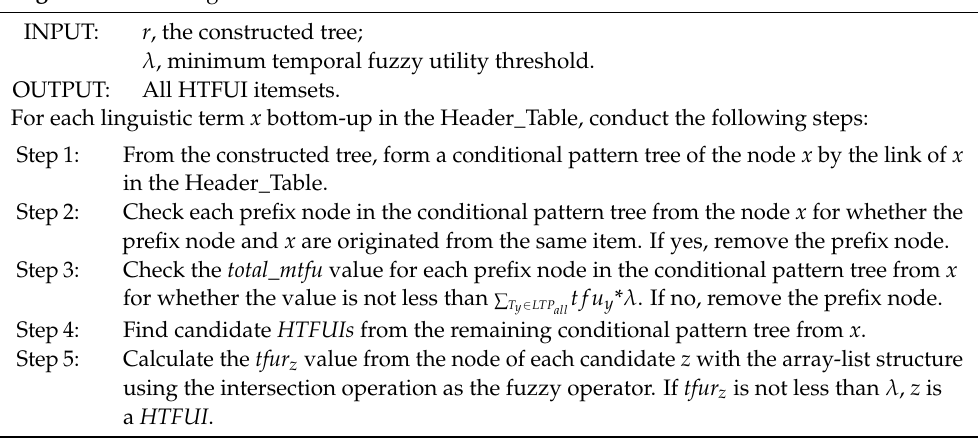
Algorithm 2: mining HTFUIs from the tree.